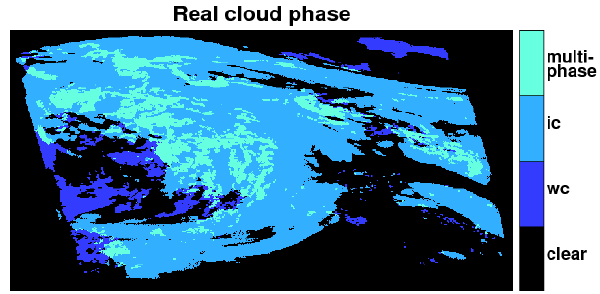
Fig. 9. Real cloud phase on the MET-8/SEVIRI grid: water clouds and ice clouds denote pixels containing exclusively liquid or iced cloud constituents. For an explanation of multi-phase clouds see the